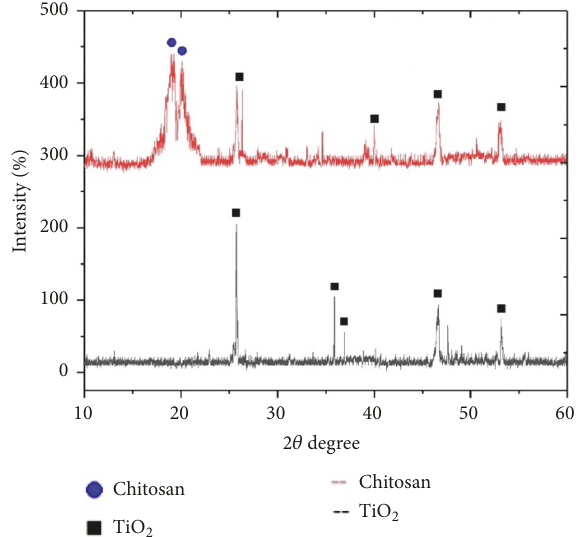
Figure 2: XRD analysis of nano-TiO 2